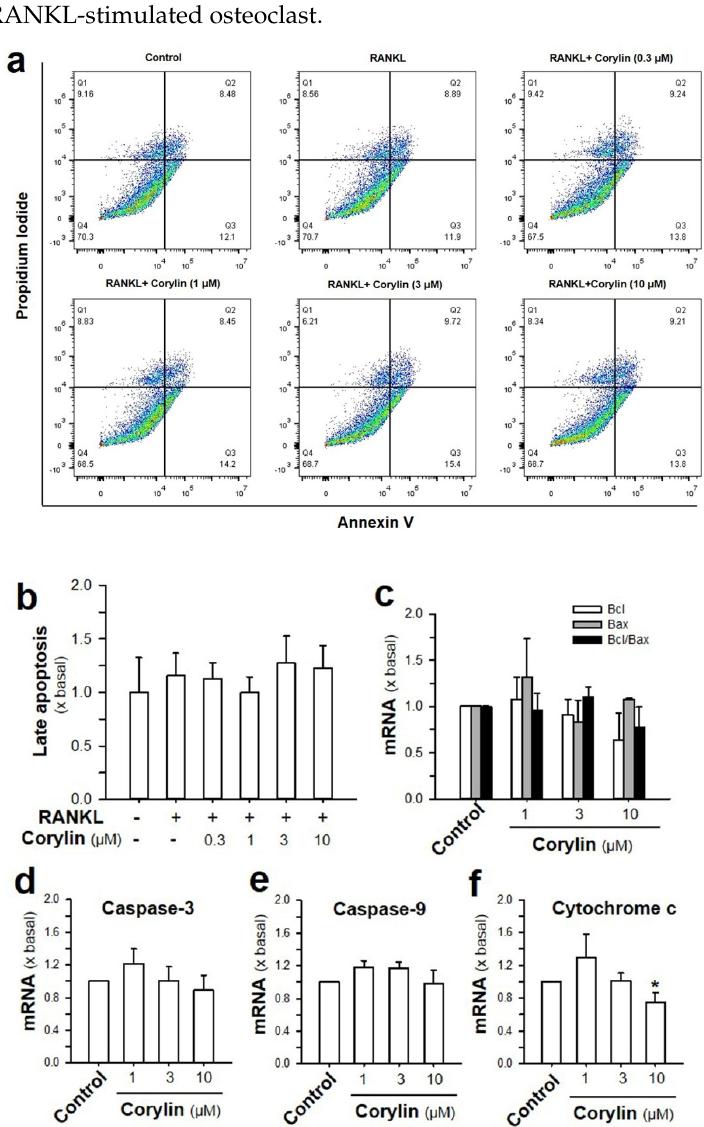
Figure 7. Corylin does not induce apoptosis in osteoclasts. ( a ) Bone marrow macrophages were cultured with 20 ng/mL RANKL in the presence or absence of corylin for 72 h. The cells were kept for 15 min in the dark for flow cytometry. ( b ) Quantification of late apoptotic cells form flow cytometry. Late apoptotic cells are propidium iodide (PI) and Annexin positive (PI/FITC +/+; Q2) ( c – f ) qRT-PCR analysis of mRNA expression of Bax, Bcl-2, caspase-3, caspase-9, and cytochrome c in bone marrow macrophages treated with corylin in the presence of RANKL (20 ng/mL) for 72 h. The value is expressed as fold to control (without corylin treatment), in mean ± SD, n = 4. * p < 0.05, compared with control.